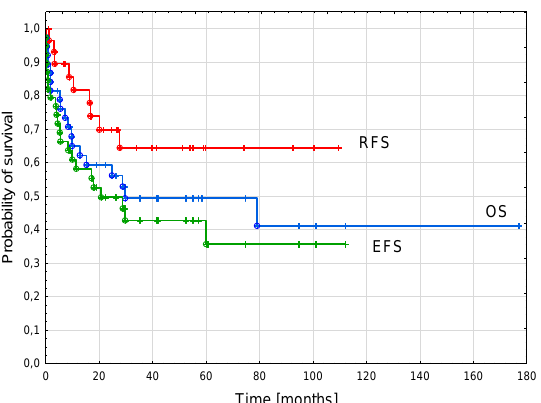
Figure 2. Survival curves of the whole cohort. Three-year overall survival (OS)—0.49 ± 0.08; three-year event-free survival (EFS)—0.43 ± 0.08, three-year relapse-free survival (RFS)—0.64 ± 0.10. The probability of a 3-year RFS was significantly higher in the patients treated in the second period compared to the first period (1.0 vs. 0.46 ± 0.11; p = 0.01). There was trend to a better 3-year EFS in the second period (0.67 ± 0.12 vs. 0.30 ± 0.1; p = 0.07). The probability of OS did not differ significantly between the groups (0.68 ± 0.12 vs. 0.43 ± 0.1, p = 0.35, Figure 3).